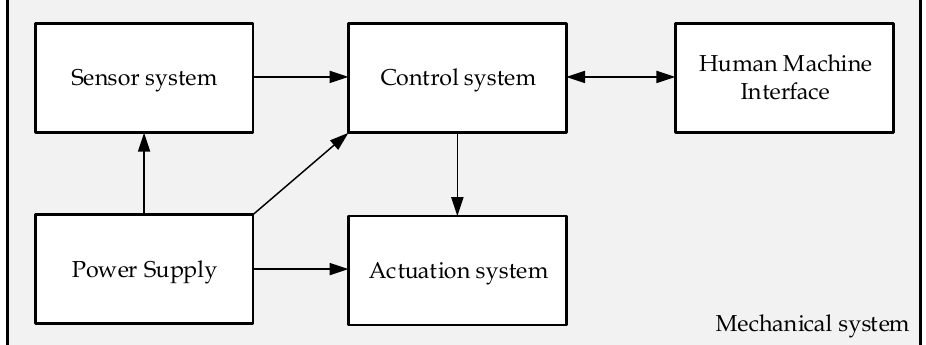
Figure 2. SwimOne: High Level